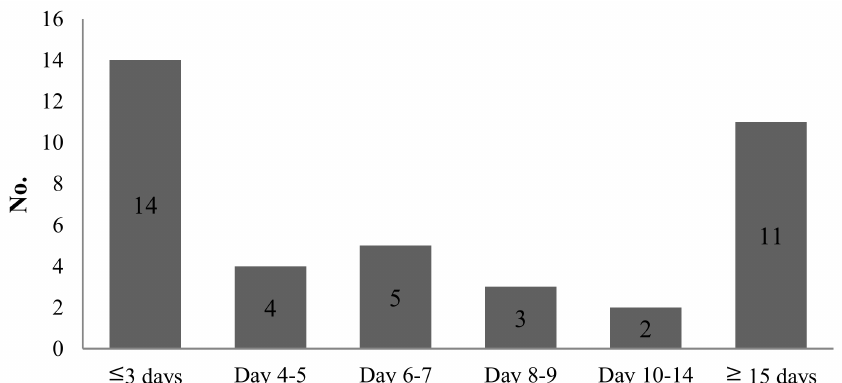
Figure 1. Time from dengue illness onset to fatality.